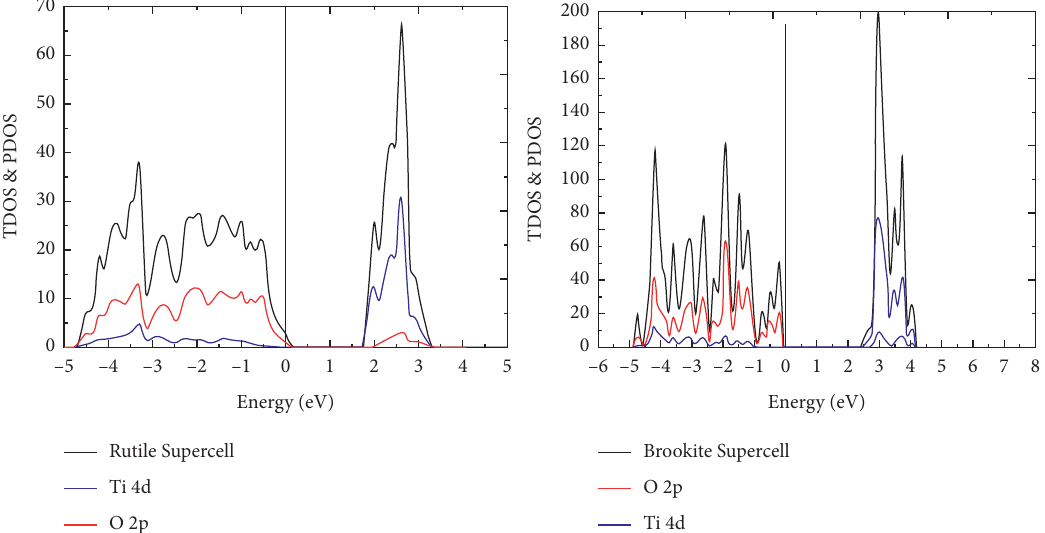
Figure 6: TDOS and PDOS of pure rutile and brookite.